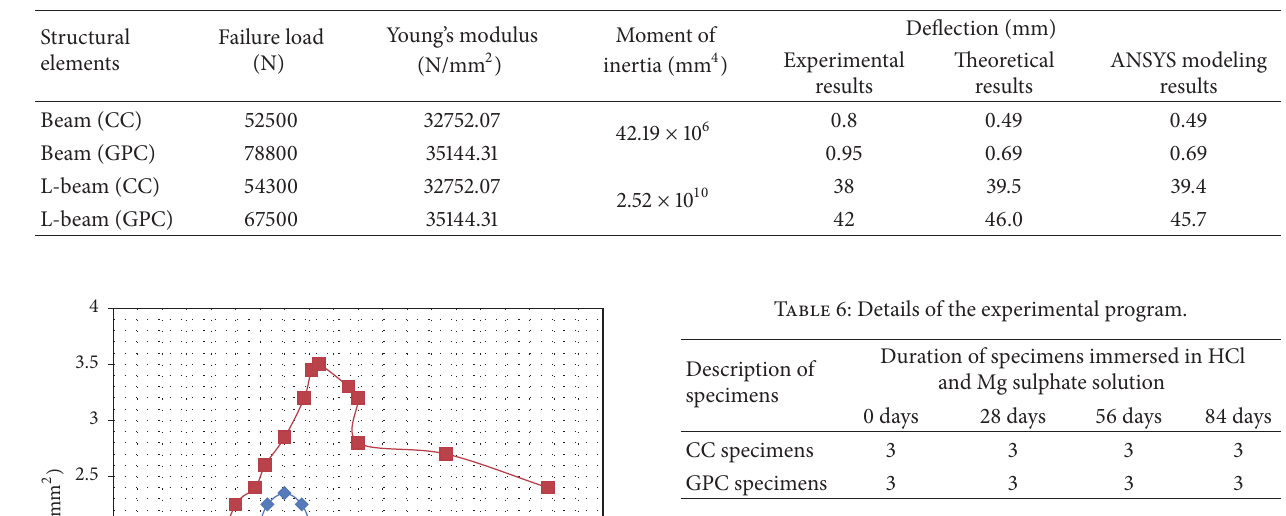
Table 5: Comparison between experimental results, ANSYS results, and mathematical prediction.